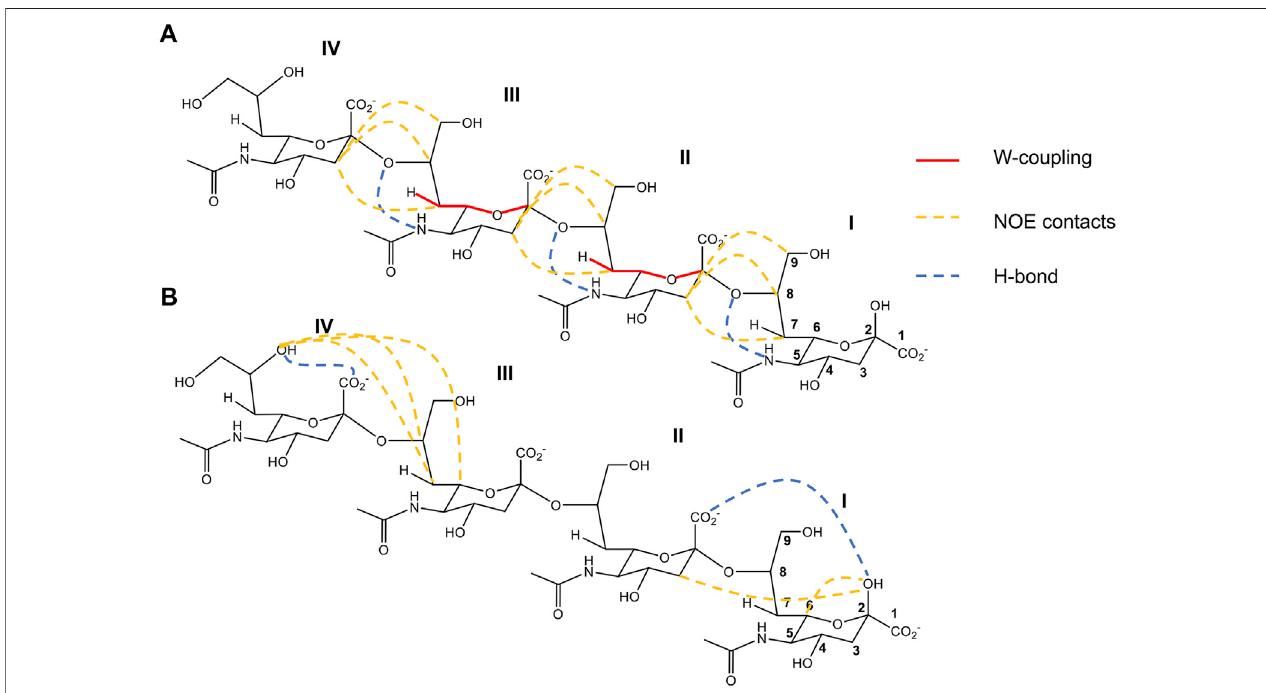
FIGURE2| 2-Dstructurerepresentationof(Sia) 4 withthemostimportantstructuralfeaturesdeducedbyBattisteletal.,2012(A)andNovakovicetal.,2021(B). (A) . Contacts compatible with the left-handed helix conformation obtained in a supercooled aqueous solution (263 K). In red lines are represented the W-coupling between C2andH7,inyellowdashedlinestheprincipaldistancesderivedfromNOEscontacts, andinbluedashed linetheintra-residueH-bond deducedbetween O8andNH5. (B) .Contactscompatiblewithamodelcombiningrigidand fl exiblesegmentsobtainedincloserphysiologicalconditions.Inyellowdashedlinesarerepresentedthe principal distances derived from NOE contacts. In blue dashed lines are the H-bonds IIO1-IOH2, consistent with a rigid conformation in the reducing end of (Sia) 4 , and IVOH8-IVO1 the principal structural motif for the most fl exible part of the nonreducing end. Figures adapted from Battistel et al. (2012) and Novakovic et al. (2021).